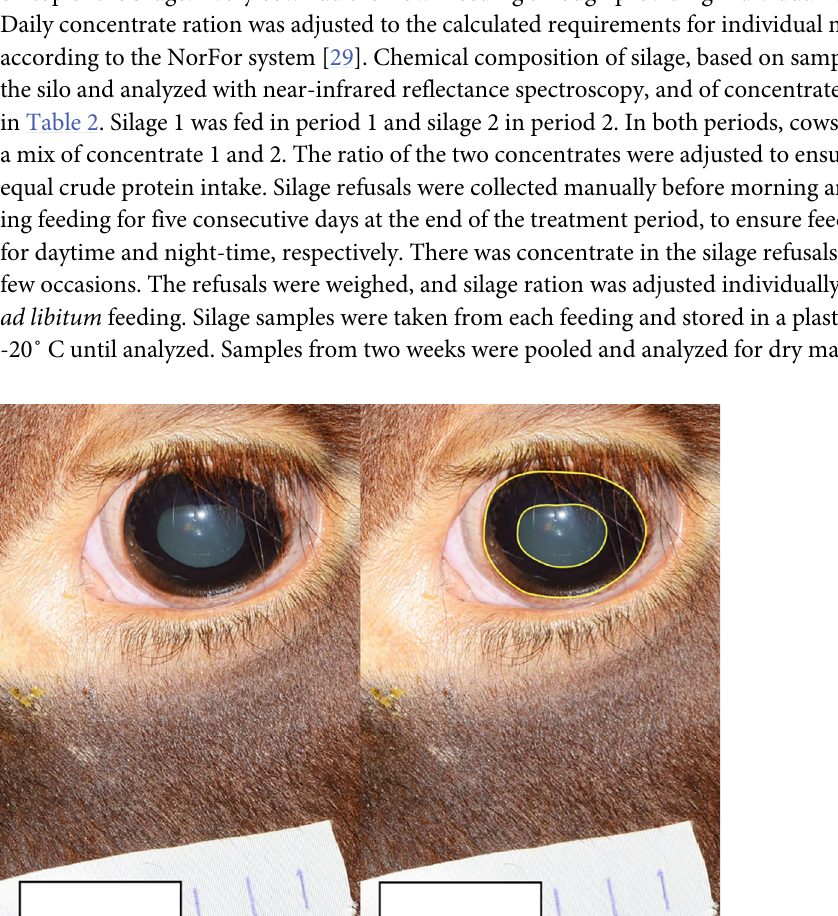
Fig 2. Spectral composition of the light used during daytime in the Light lab. (A) Red light treatments, (B) Blue light treatments, and (C) White light treatments.